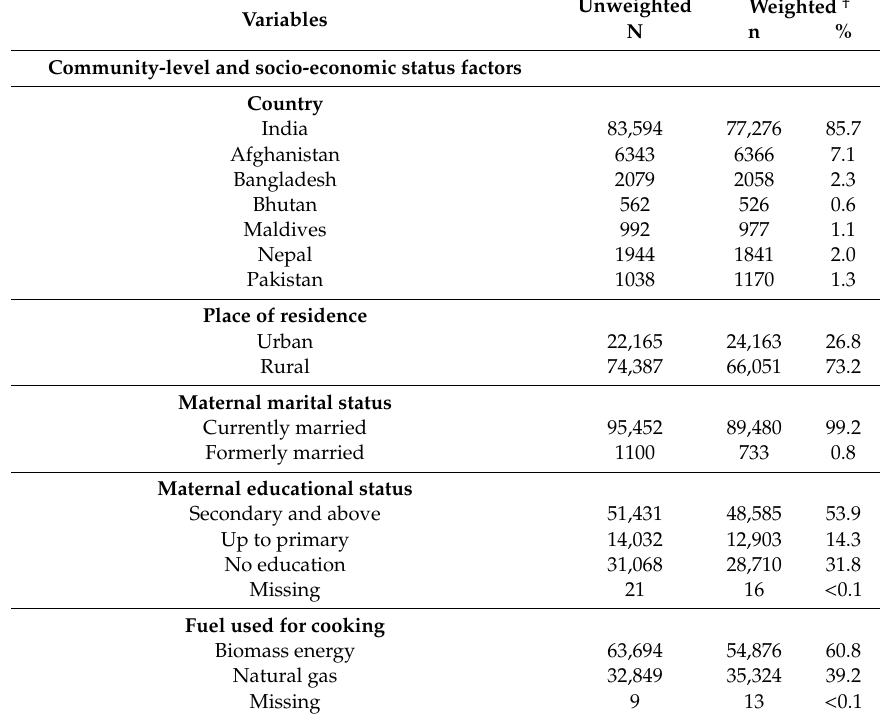
Table 3. Prevalence of community-level, socio-economic status, maternal and child characteristics and perinatal health services of most recent live-births two years before the interview in pooled data from seven countries in South Asia (N =